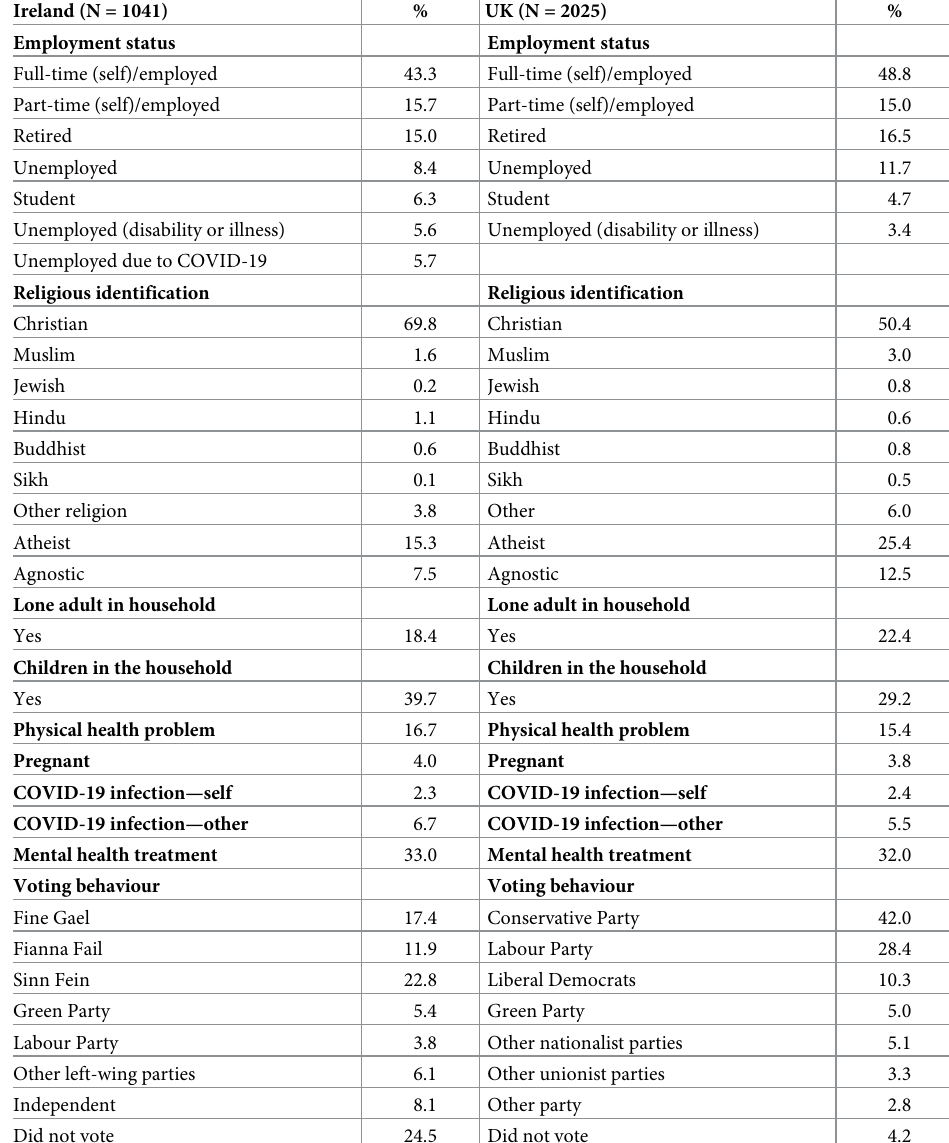
Locus of control . The Locus of Control Scale (LoC) [28] measures internal (e.g., ‘My life is determined by my own actions’) and external locus of control. The latter has two components, ‘Chance’ (e.g., ‘To a great extent, my life is controlled by accidental happenings’) and ‘Powerful Others’ (e.g., ‘Getting what I want requires pleasing those people above me’). Each subscale was measured using three questions and a seven-point Likert scale that ranges from ‘strongly disagree’ (1) to ‘strongly agree’ (7). Higher scores reflect higher levels of each construct. The internal reliabilities of the Internal and Chance subscale scores in the Irish sample were slightly lower than desirable ( α = .67 &.63, respectively) but somewhat stronger for the UK sample ( α = .71 &.70, respectively), while those for the Powerful Others subscale scores were good in both samples (Ireland: α = .78; UK: α =